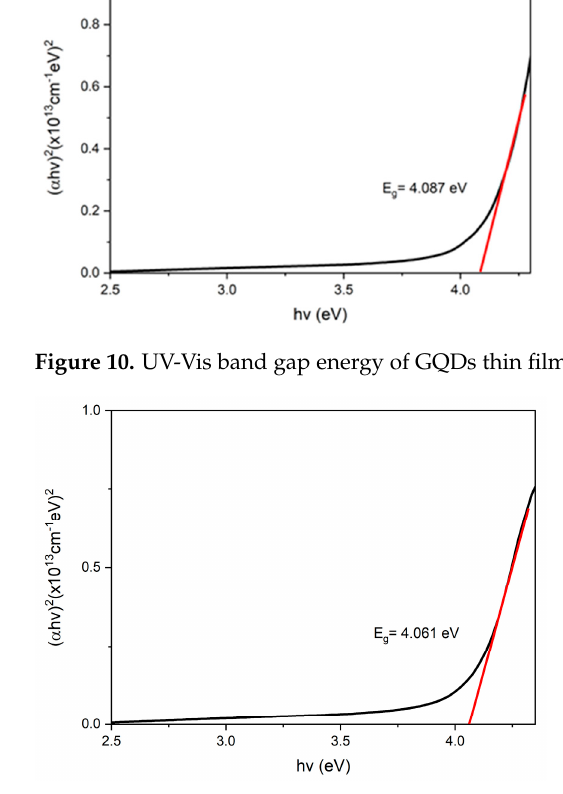
Figure 11. UV-Vis band gap energy of PVA thin film.